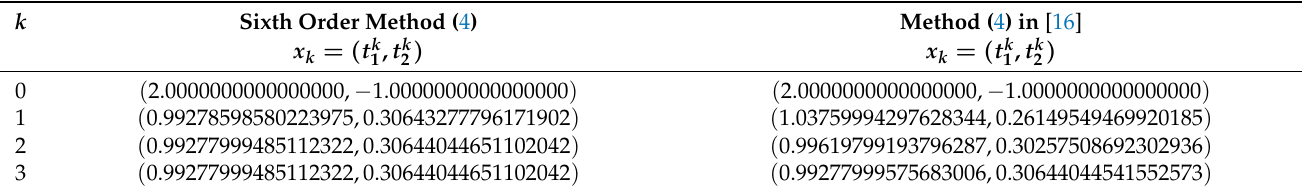
Table 5. The Sixth-Order Method (4) and the Noor–Waseem Sixth-order Extension Method in [16].